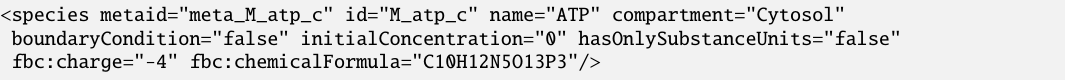
Table 1: Examples of chemical formulas written using the Hill System. As described in Section